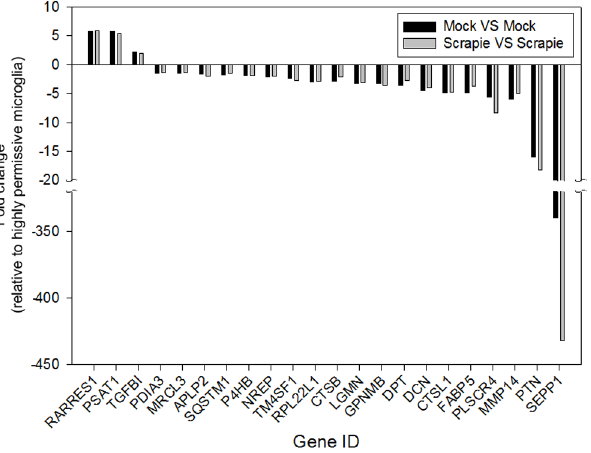
Fig 4. Transcript fold-change in highly permissive microglia compared to poorly permissive microglia. Transcriptional profiles of highly permissive and poorly permissive microglia clones under two experimental conditions (mock [black bars] or scrapie [gray bars] inoculation) were compared. All the genes with differential transcription in both comparisons ( P < 0.05 [Baggerley ’ s test and Bonferroni correction]) and known biological function across three culture replicates are shown. Gene IDs are on the x — axis. The fold change in transcription relative to highly permissive microglia is on the y — axis. Thus, positive fold changes indicate upregulation in highly permissive microglia and negative fold changes indicate upregulation in poorly permissive